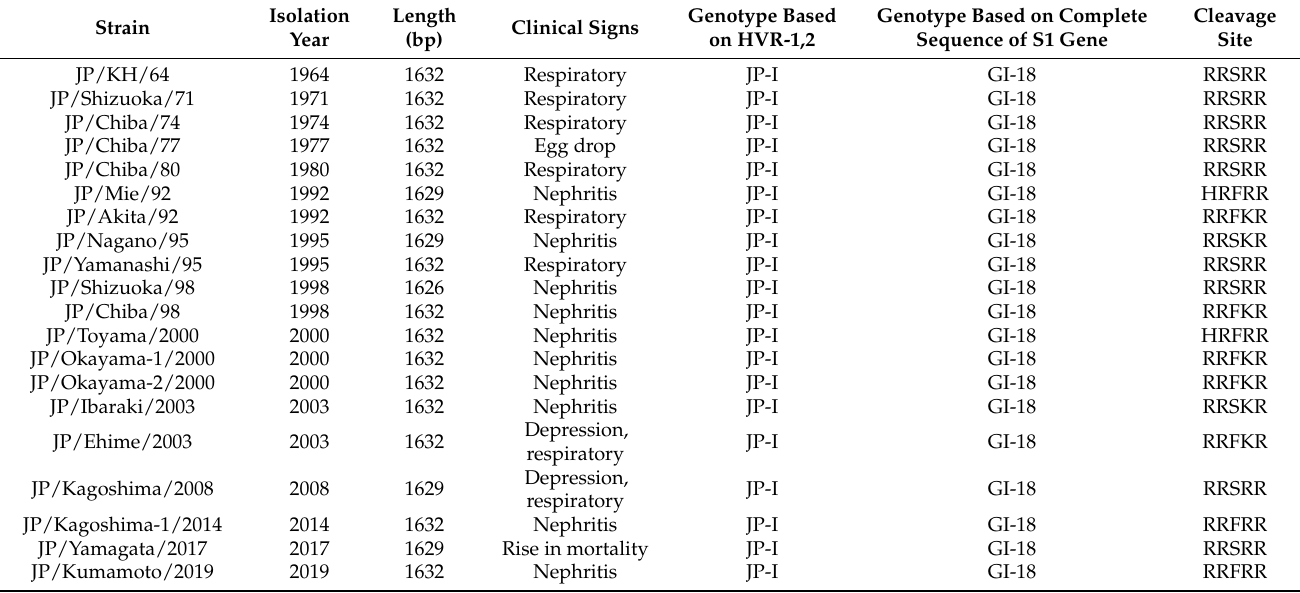
Table 1. Japanese IBV strains employed in this